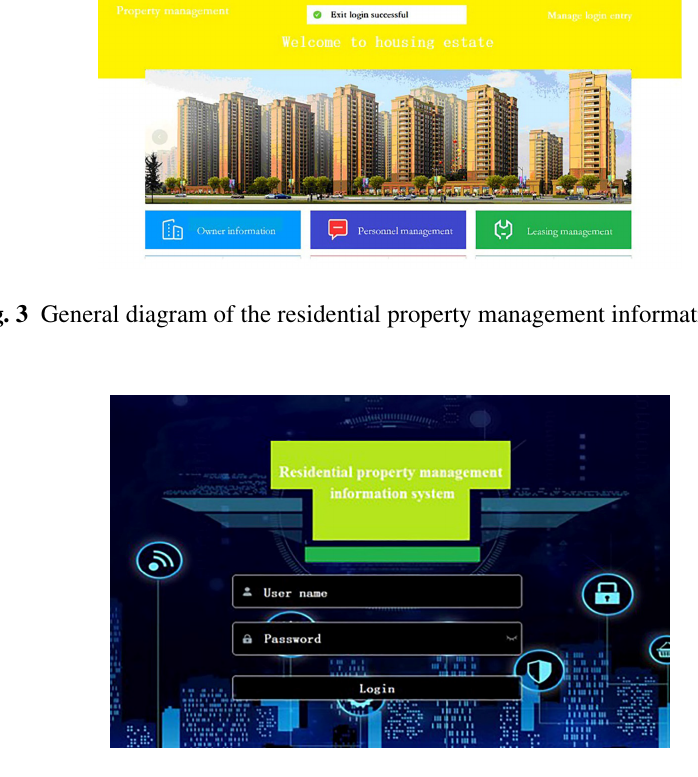
Fig. 4 Residential property management information system